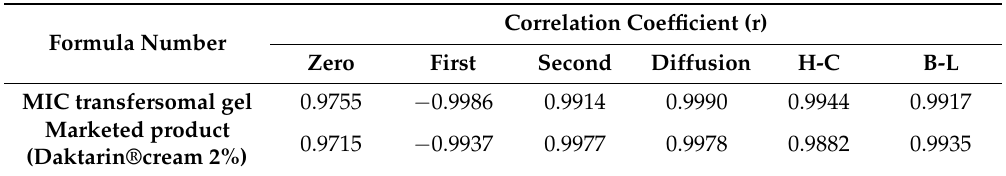
Table 8. The calculated correlation coefficients for the in vitro permeation of MIC from transfersomal gel and the marketed product employing different kinetic orders or systems.